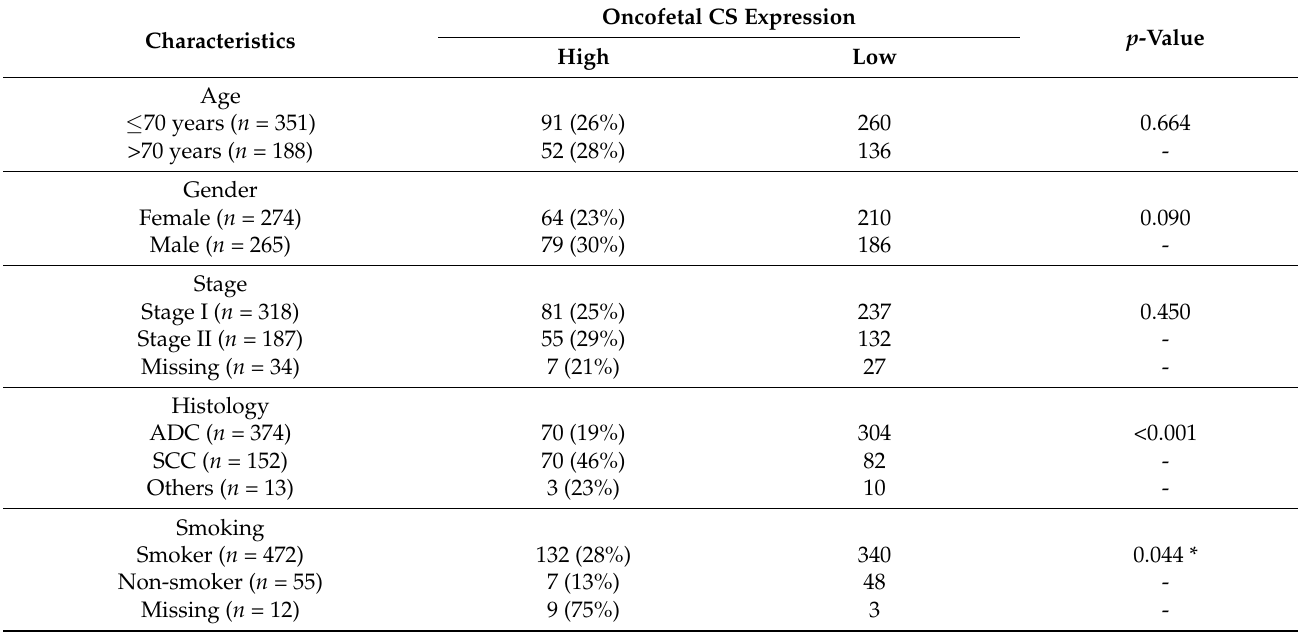
Table 1. Relationship between oncofetal CS expression and clinicopathological parameters in 539 NSCLC cases by immunohistochemistry.